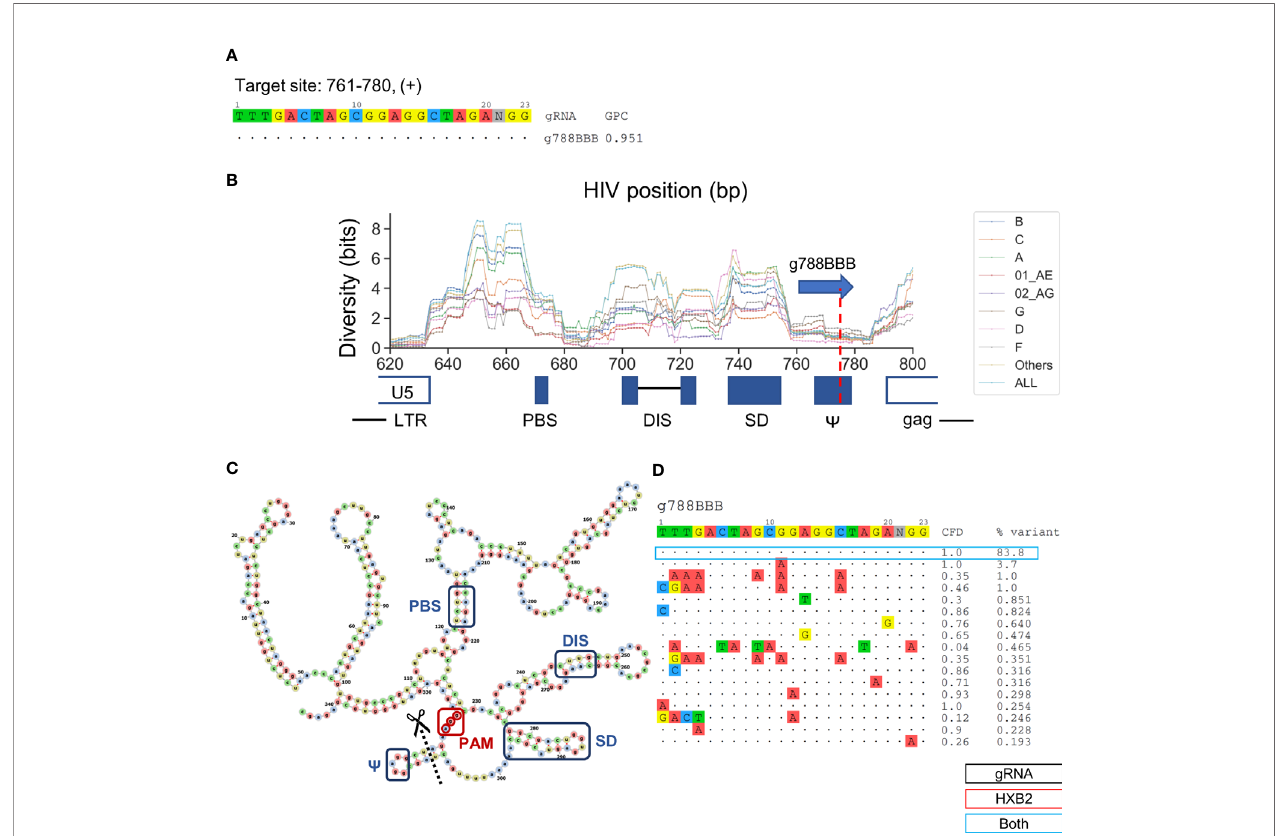
FIGURE 5 | Low diversity in the SL3 region is an ideal target for the selection of gRNA sequence that provides high predicted global patient coverage. (A) All candidate gRNAs targeting position 761-780 (+) among 1,330 candidate gRNAs. (B) The subtype-speci fi c sequence diversity across the HIV-1 genome between position 600 and 800. The predicated target region showed a local trough fl anking by g788BBB target sites. g788BBB was predicted to cleave nucleocapsid binding site, Y . (C) Predicted HXB2 untranslated region (UTR) secondary structure with the PBS (primer binding site), DIS (dimer initiation site), SD (splicing donor), and Y regions labeled with blue, g788BBB PAM labeled with red, and cleavage site labeled with black. Secondary structure was predicted using RNAfold (Gruber et al., 2008) and visualized using VARNA (Darty et al., 2009). (D) Sequence variant pro fi les and corresponding CFD score between chosen gRNA and HIV-1 variants. “ HXB2 ” label next to the % variant represent the variant frequency of the sequence that possessed identical sequence against